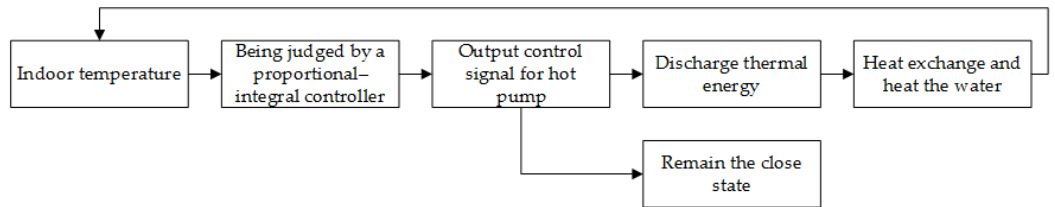
Figure 3. Flow chart about the control scheme for the discharge sector.